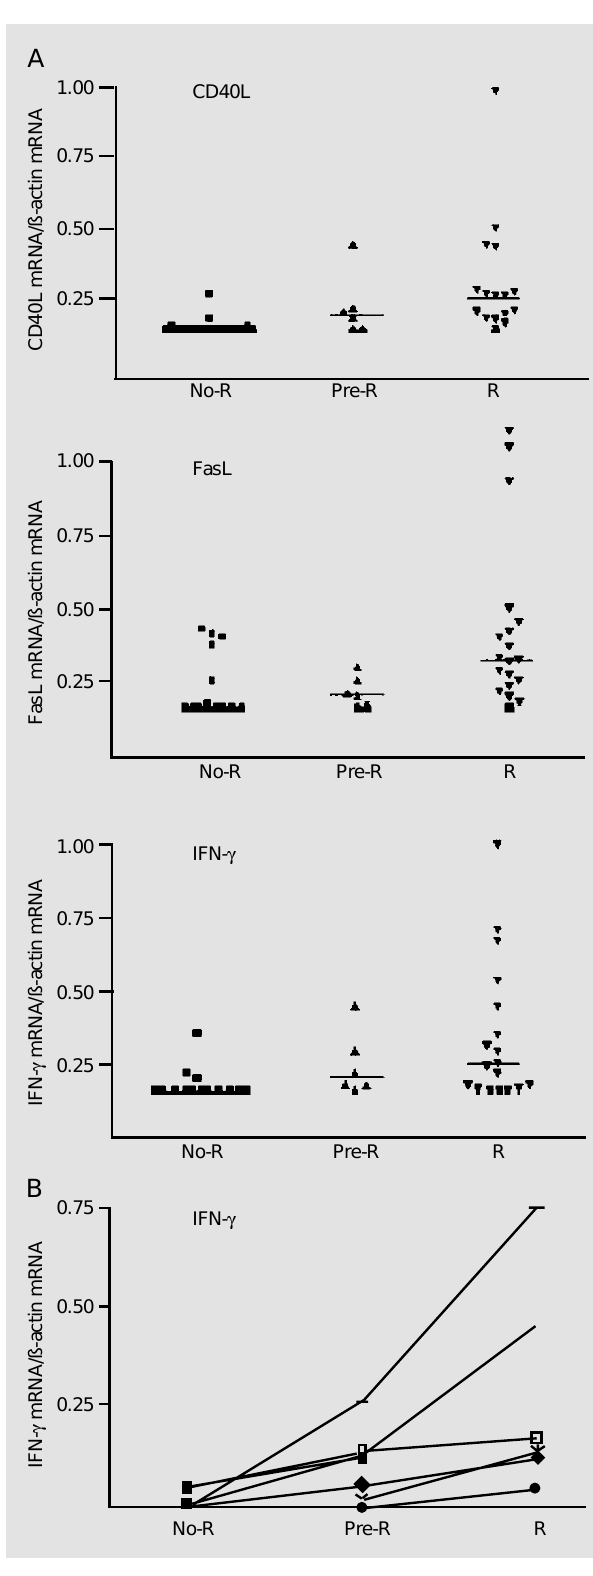
Figure 1. Expression of CD40L, IFN- g and FasL genes in endomyocardial biopsies. A , CD40L, FasL and IFN- g mRNA levels (target mRNA/ß-actin mRNA) in the samples without rejection collected more than 15 days before or after rejection (No-R), in the samples without rejection collected 7 to 15 days before rejection (Pre- R), and in the samples with rejection (R). The horizontal lines represent the median values. B , Kinetics of intragraft IFN- g mRNA levels in six patients for whom no rejection, pre-rejection, and rejection biopsy samples were available. Each line represents one patient. CD40L, CD40 ligand; IFN- g , interferon- g ; FasL, Fas